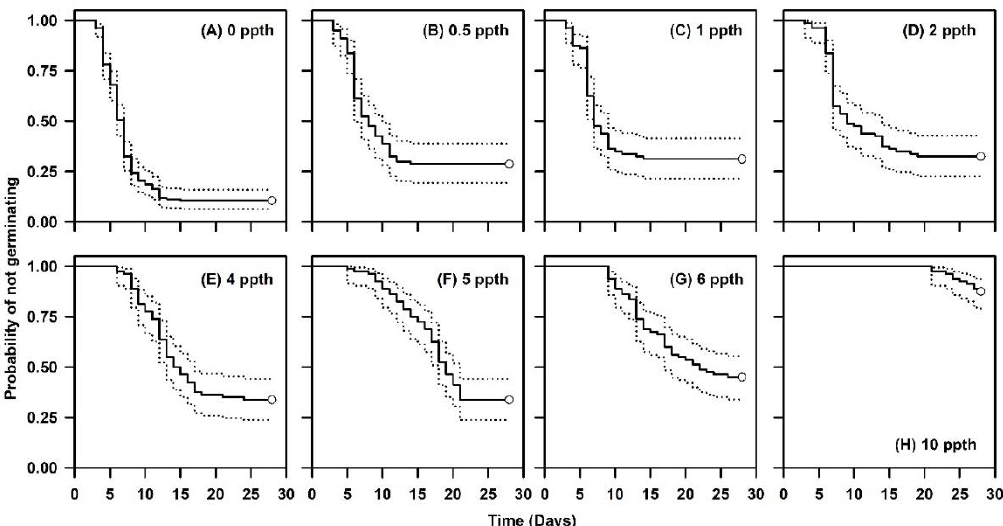
Figure 5. Kaplan–Meier estimates of survivor functions for Linum arenicola seeds exposed to various salinity levels. Dotted lines represent pointwise 95% confidence intervals. Open circles represent censored observations.